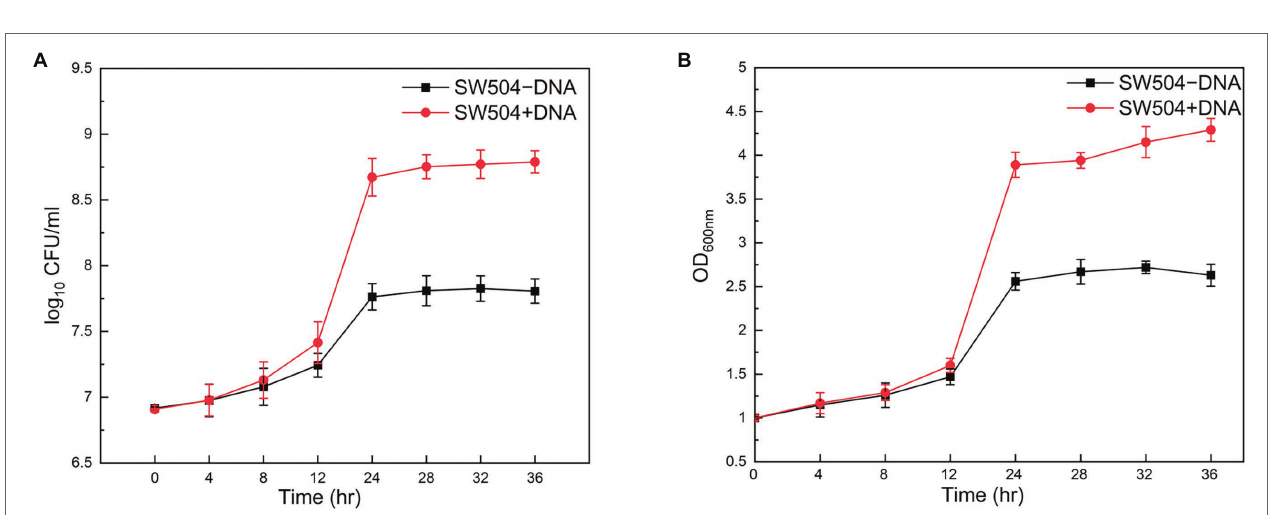
FIGURE 10 | Susceptibility of Myxococcus xanthus SW504 cells to the extrinsically supplied DNA. Growth curves of Myxococcus xanthus SW504 cells in the CTT medium supplemented with (+) or without ( − ) 0.5% ( w / v ) calf thymus DNA were plotted by measuring the optical density at 600 nm (A) and colony forming unit (CFU) counting (B)